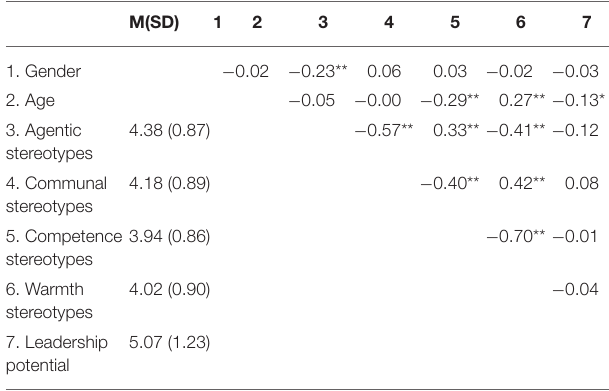
TABLE 1 | Study 1: means, standard deviations and correlation matrix for specified